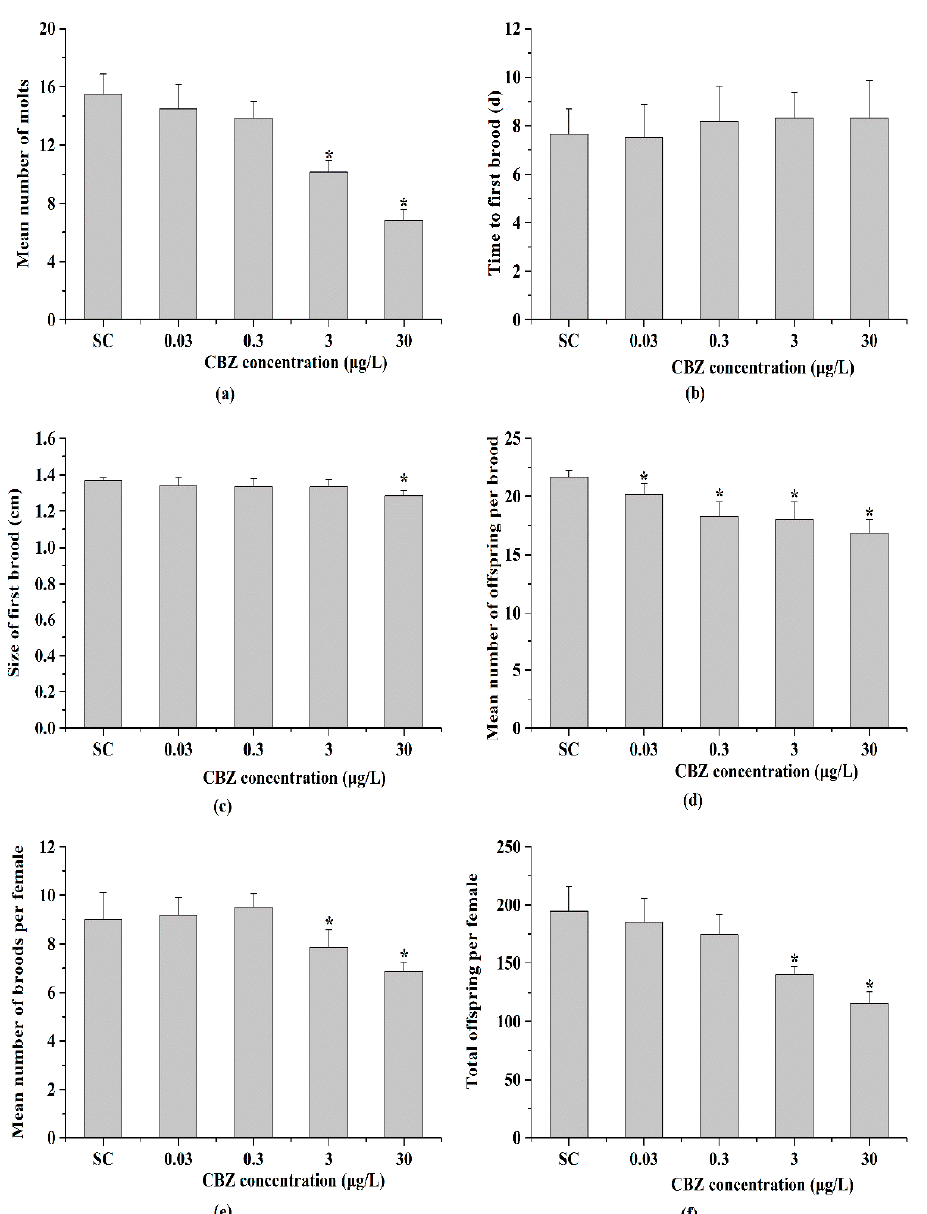
Figure 3. The individual endpoint measurements after the chronic exposure (21 d). ( a ) Mean number of molts; ( b ) Time to first brood (days); ( c ) Size of the first brood (cm); ( d ) Mean number of offspring per brood; ( e ) Mean number of broods per female; ( f ) Total offspring per female. Results are presented as mean ± SD , N = 6. * p < 0.05.